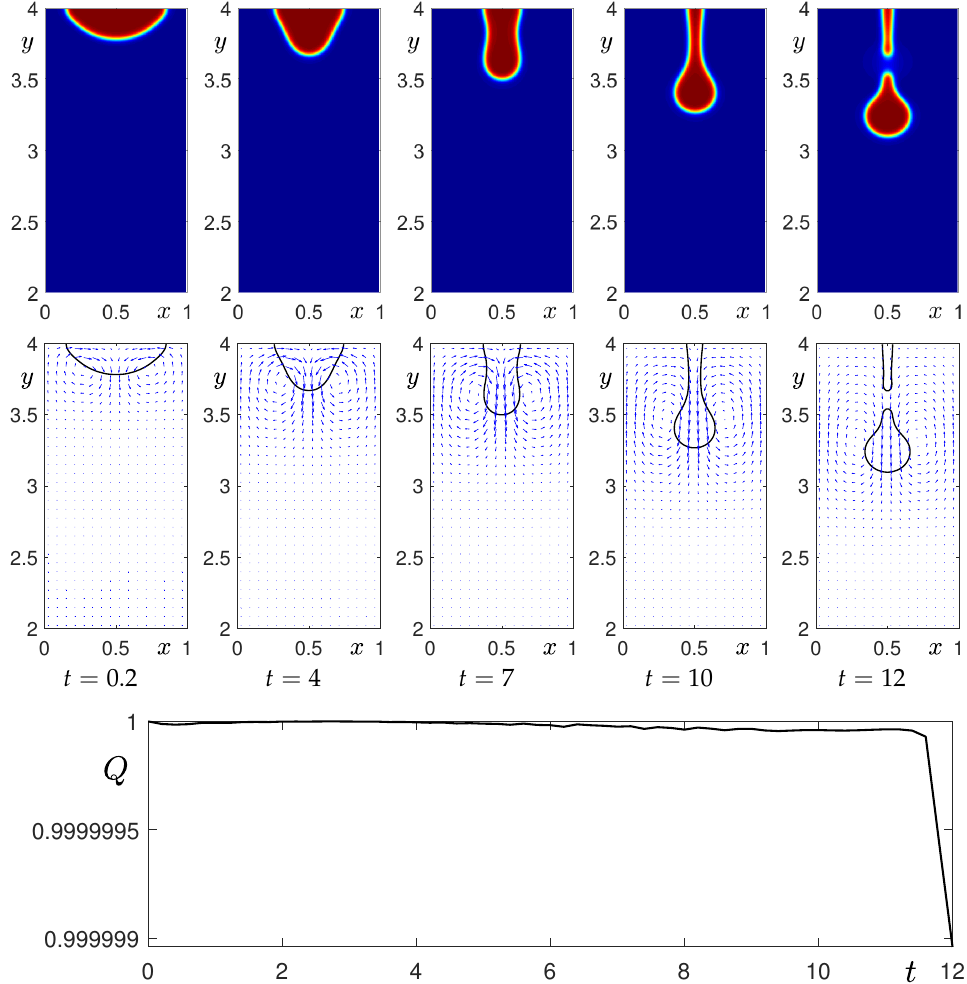
Figure 9. The top and middle rows display the snapshots of φ and velocity field for dripping droplet. The computational moments are shown under each figure. The bottom row plots the evolution of Q n